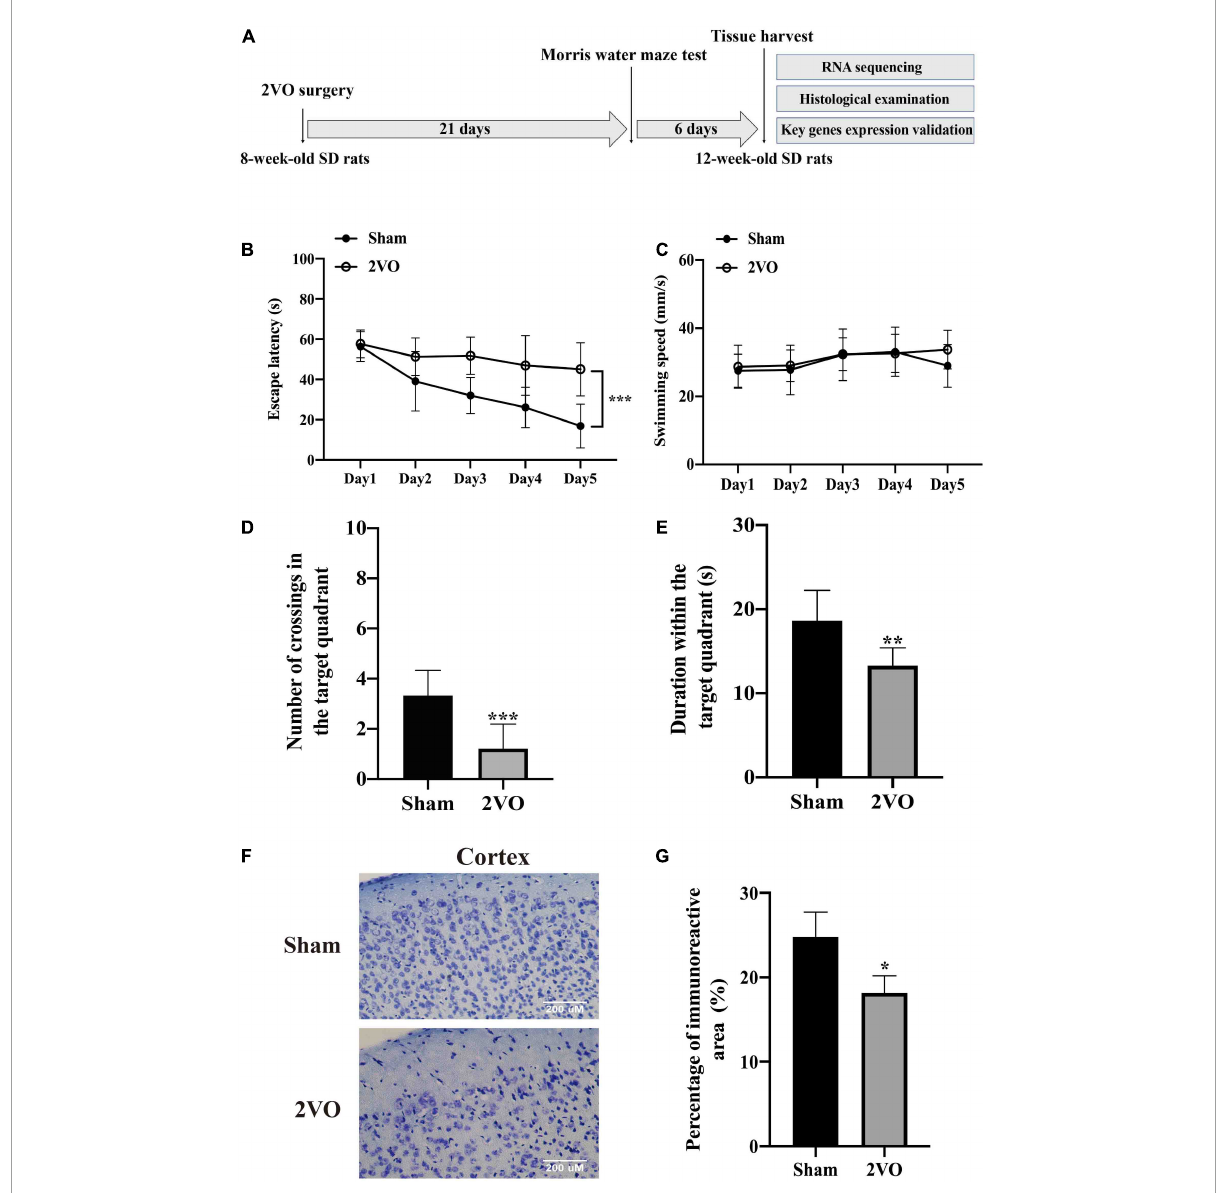
FIGURE2 Cognitive decline and neuronal injury in rats with 2VO compared with sham rats. (A) Timeline of the in vivo experiment. 8-week-old SD rats were subjected to the bilateral common carotid artery occlusion, followed by the cognitive impairment test after 3 weeks. The cerebral cortices were finally collected from the 12-week-old SD rats. 2VO: bilateral common carotid artery occlusion. (B) Escape latency of rats in the navigation test for five consecutive days ( n = 9). (C) Swimming speed of rats during the navigation test ( n = 9). (D) Number of crossings of rats to find platforms previously located in the probe test ( n = 9). (E) Duration time in the target quadrant in the probe test ( n = 9). (F) Representative images of Nissl staining in the cortex of 2VO and sham rats. (G) Quantification of Nissl staining ( n = 3). Results are presented as mean ± SD. * P < 0.05, ** P < 0.01, *** P < 0.001 vs .